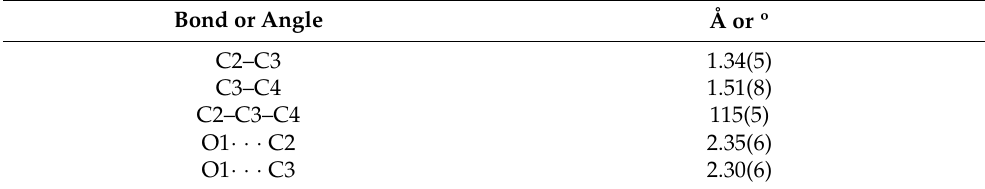
Figure 7. X-ray structure of the (C 4 H 7+ ‧ OH 2 )(Cl 11 − ) ( III b ) with two locations of the cation ( a ), and more detailed representation of the C 4 H 7+ ‧ OH 2 adduct ( b ). Table 4. Selected geometric parameters of cationic adduct III b (averaged over two positions) according to X-ray data.